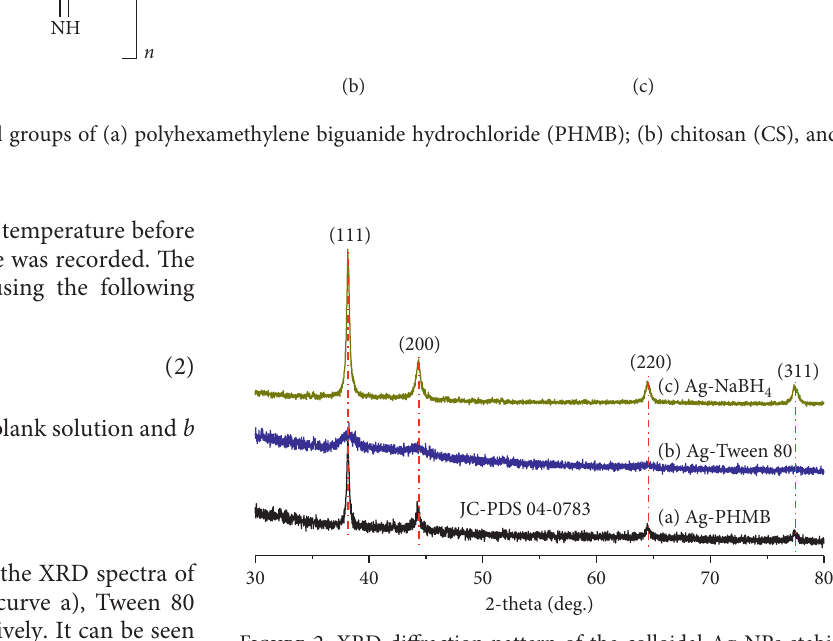
Figure 2: XRD diffraction pattern of the colloidal Ag-NPs stabi- lized by (a) PHMB, (b) Tween 80, and (c) NaBH 4 .